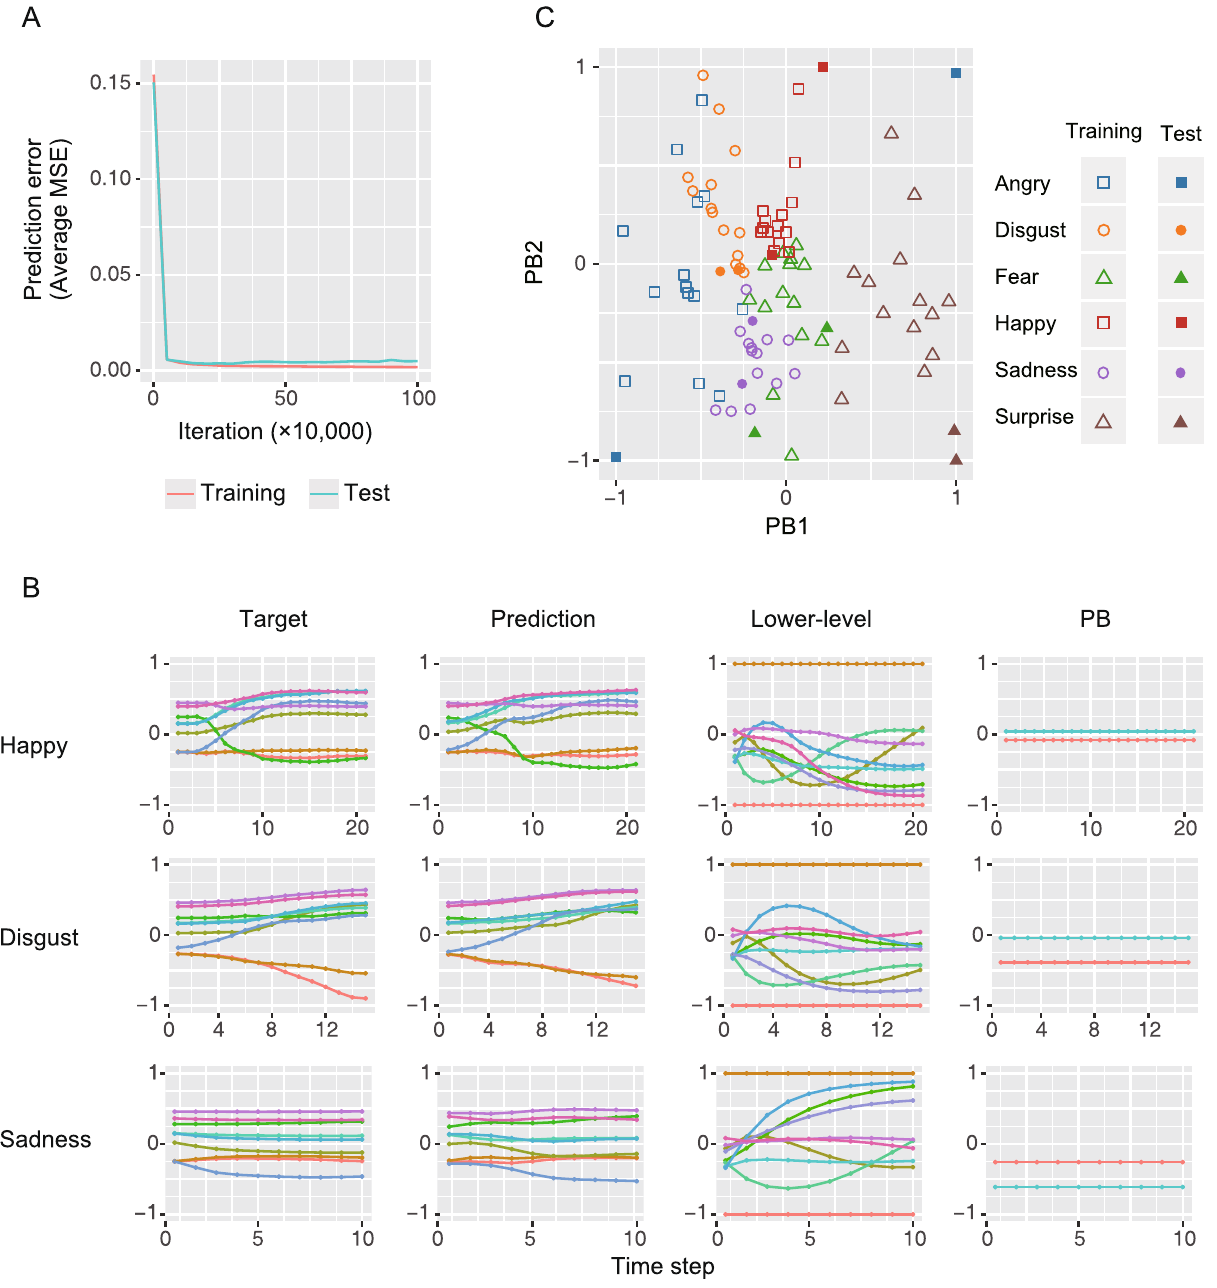
Figure 2. ( A ) The learning curves. The X axis indicates the number of iterations in the training process. The Y axis indicates the prediction error (MSE), which is averaged over the sequence length, feature numbers, sequence numbers, and eightfold cross-validation. Both the prediction error for training sequences as well as the prediction error for test sequences are shown in this figure. ( B ) Examples of target sequences, predicted sequences, lower-level neuron activities and PB activities for the test target sequences. For lower-level neuron activity, 10 representative neurons among 500 neurons are shown. ( C ) The PB activity representation. The color indicates emotional categories. The outlined symbols express the PBs corresponding to the training sequences, while the filled symbols express those to the test sequences. MSE mean squared error, PB parametric